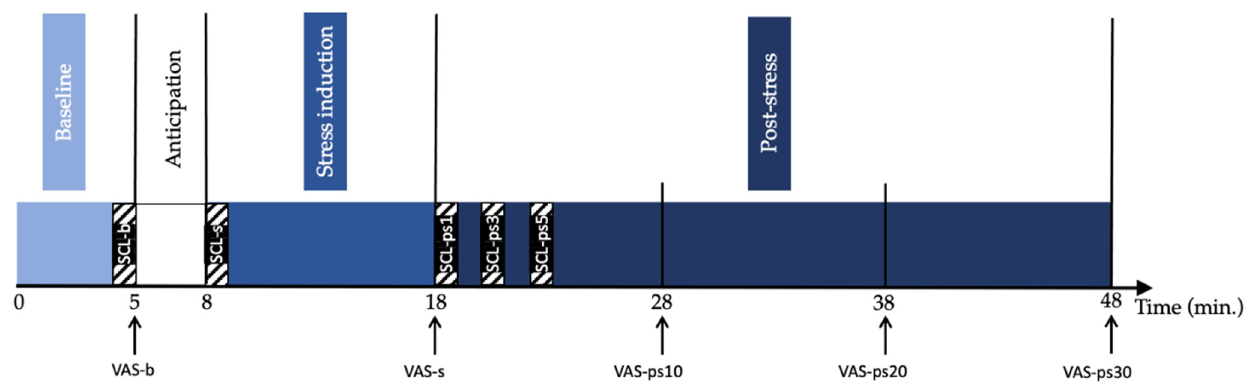
Figure 1. Trier Social Stress Test procedure. Hatched rectangles represent one-minute epochs where skin conductance level was extracted, and arrows represent moments where self-reported stress measurements were taken. SCL-b = SCL at baseline. SCL-s = SCL at stress induction. SCL-ps1, SCL-ps3 and SCL-ps5 = SCL at 1, 3 and 5 min post-stress, respectively. VAS-b = self-reported stress at baseline. VAS-s = self-reported stress after stress induction. VAS-ps10, VAS-ps20 and VAS-ps30 = self-reported stress at 10, 20 and 30 min post-stress, respectively. SCL = skin conductance level. VAS = visual analogue scale.